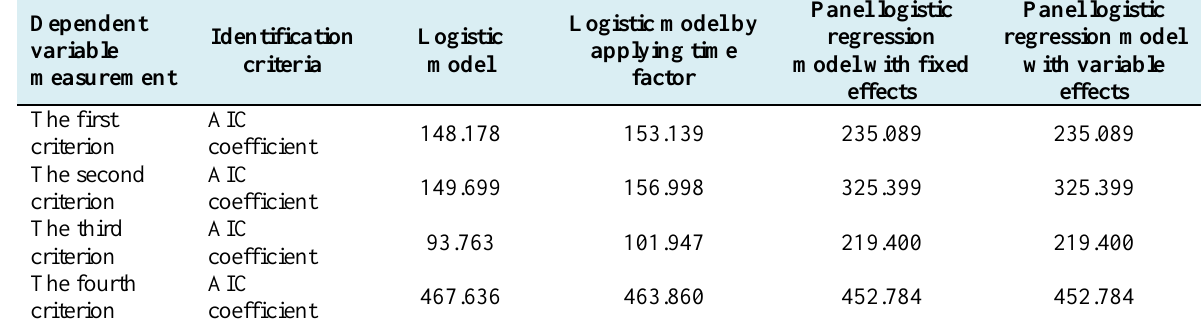
Table 4. Results of AIC statistics for the model of research